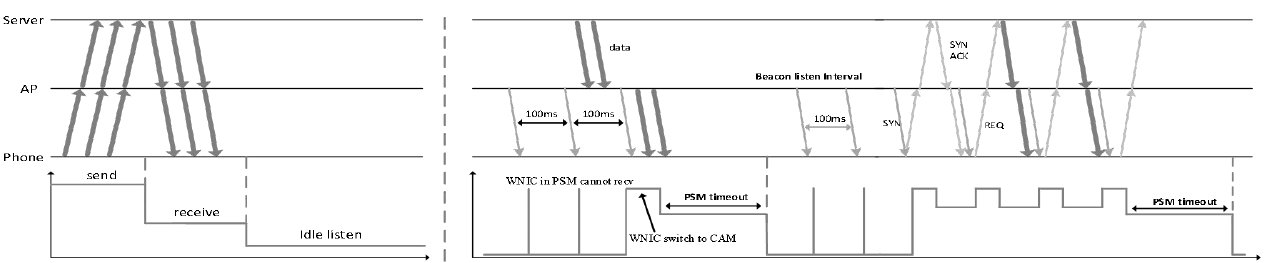
Fig. 2 . (b) Network transmission behavior impact on suspend/ resume mode switch network environments on signal strength, we ran some applications to present a conventional network transmission behavior. Games, browsers, videos and other typical applications were selected for user experience respectively.